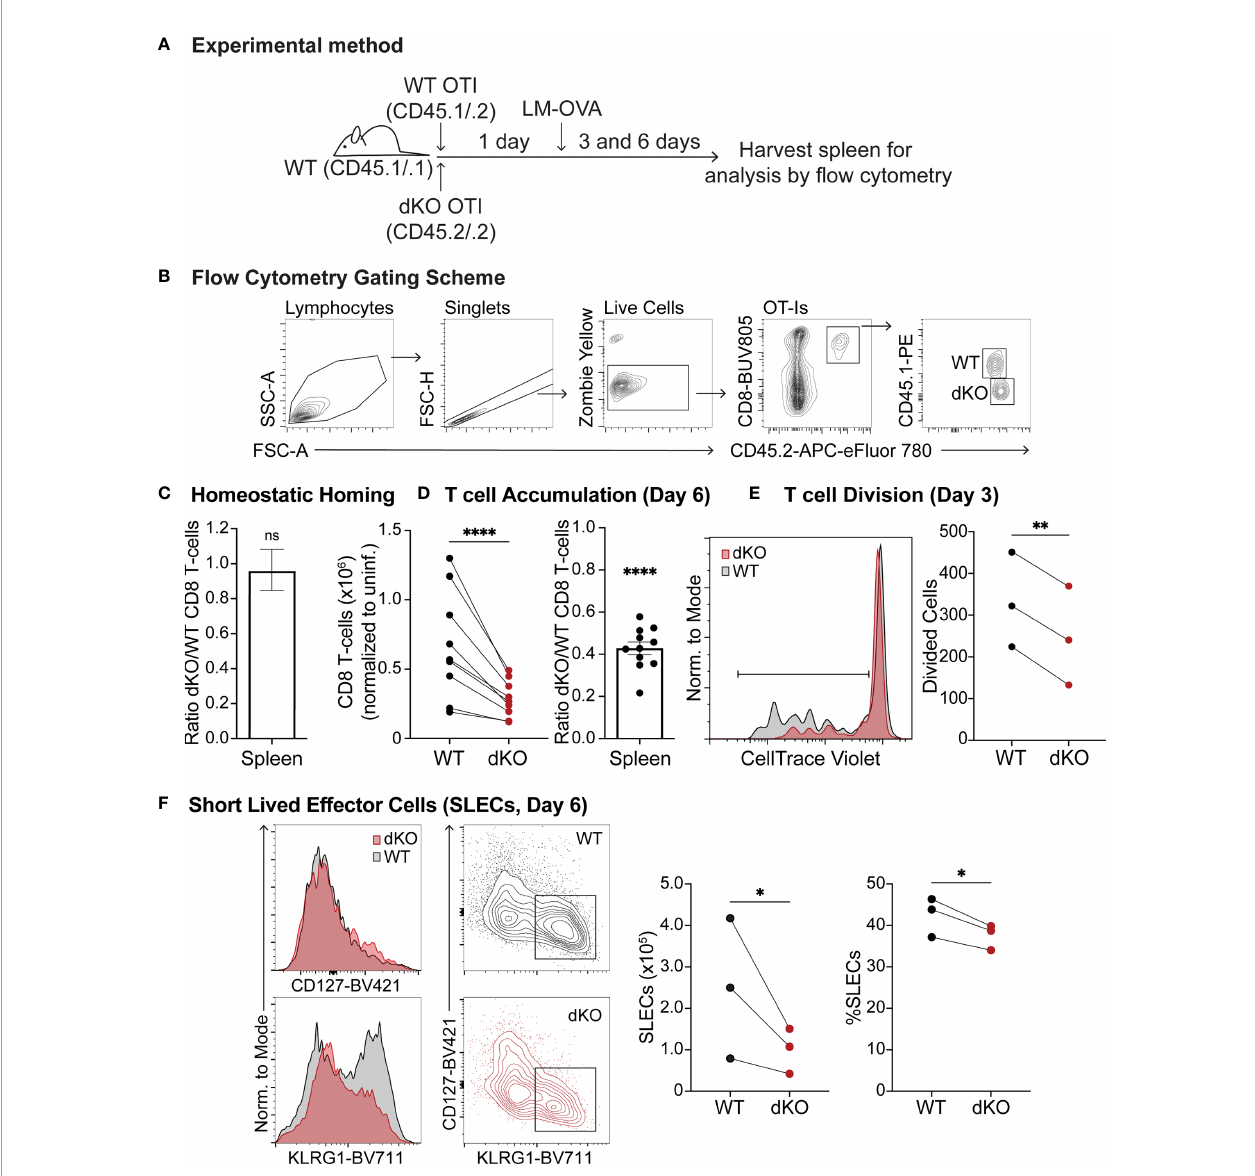
FIGURE 1 | Ena/VASP de fi ciency reduces T cell accumulation in response to Listeria Monocytogenes challenge. Congenically distinct naïve WT CD45 .1/.2 OT-I and EVL/ VASP dKO CD45 .2/.2 OT-I T cells were isolated from donor mice and transferred at a 1:1 ratio I.V. into WT CD45 .1/.1 recipient mice. (A) Graphical schematic of the experimental method. (B) Representative fl ow cytometry gating scheme used to detect transferred T cells. (C) WT and EVL/VASP dKO naïve T cells have similar persistence in vivo . 1×10 6 WT and EVL/VASP dKO naïve OT-I CD8 + T cells, were co-transferred I.V. into uninfected WT CD45 .1/.1 recipient mice and spleens were harvested 6 days later